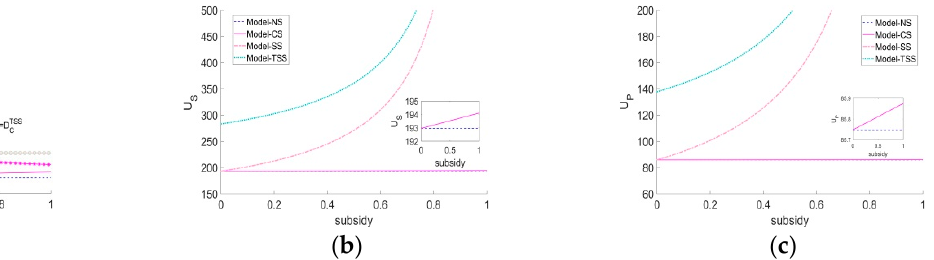
Figure 4. Impacts of green traceability factors η and scenarios. ( a ) Market demand for two types of agricultural products. ( b ) Supplier utility. ( c ) Platform utility.